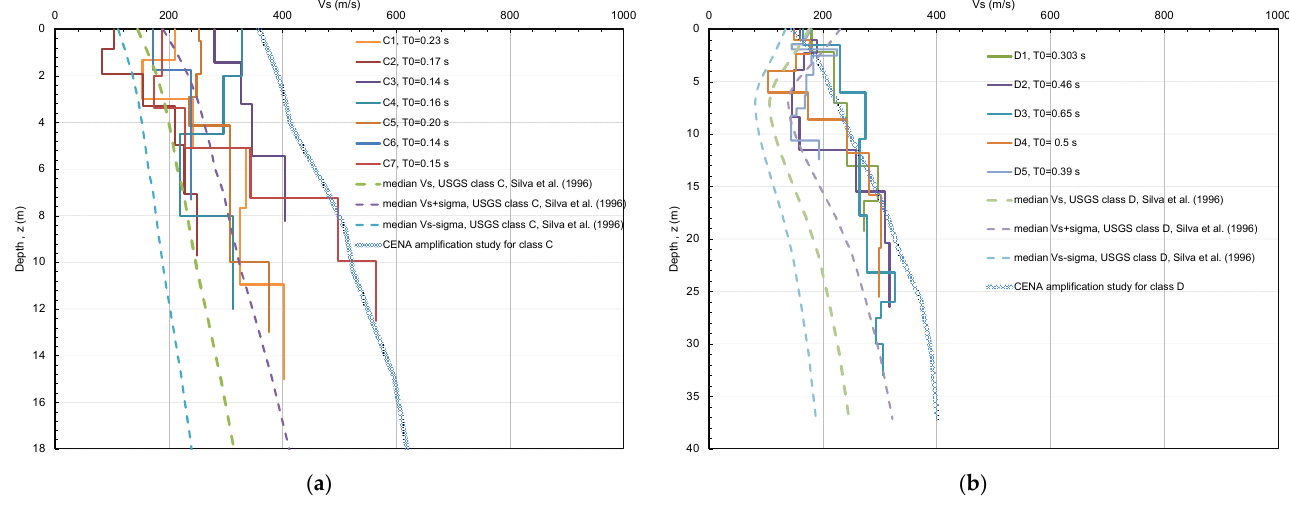
Figure 4. ( a ) Vs profiles for selected class D, and ( b ) Vs profiles for selected C sites in Montreal compared with the median Figure 4. ( a ) V s profiles for selected class D, and ( b ) V s profiles for selected C sites in Montreal compared with the median Vs profiles from Silva et al. [36] and the median Vs profile for Central and Eastern North America (CENA) sites [37]. V s profiles from Silva et al. [36] and the median V s profile for Central and Eastern North America (CENA) sites [37].